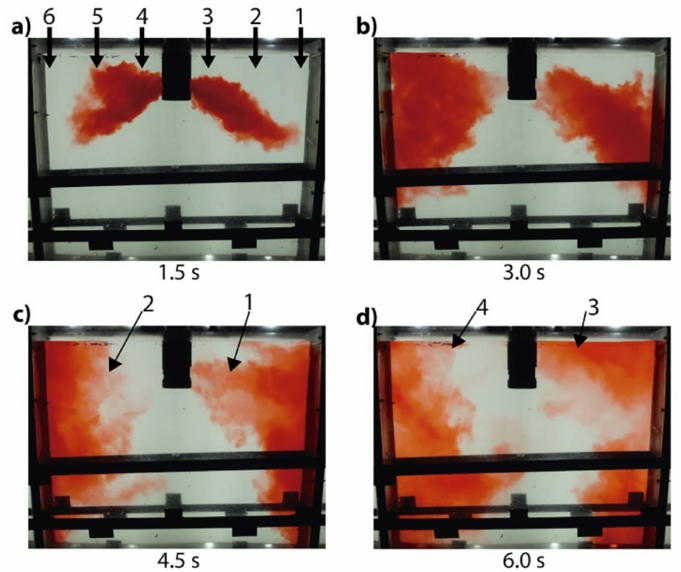
Figure 25. Tracer mixing in the mold model using nozzle B with clogging. ( a ) A total of 1.5 s after injection. ( b ) A total of 3 s after injection. ( c ) A total of 4.5 s after injection. ( d ) A total of 6 s after injection. The numbers in figure ( a ) indicate the position of the sensors, the numbers in figures ( c , d ) are explained in the part of the text where the figure is